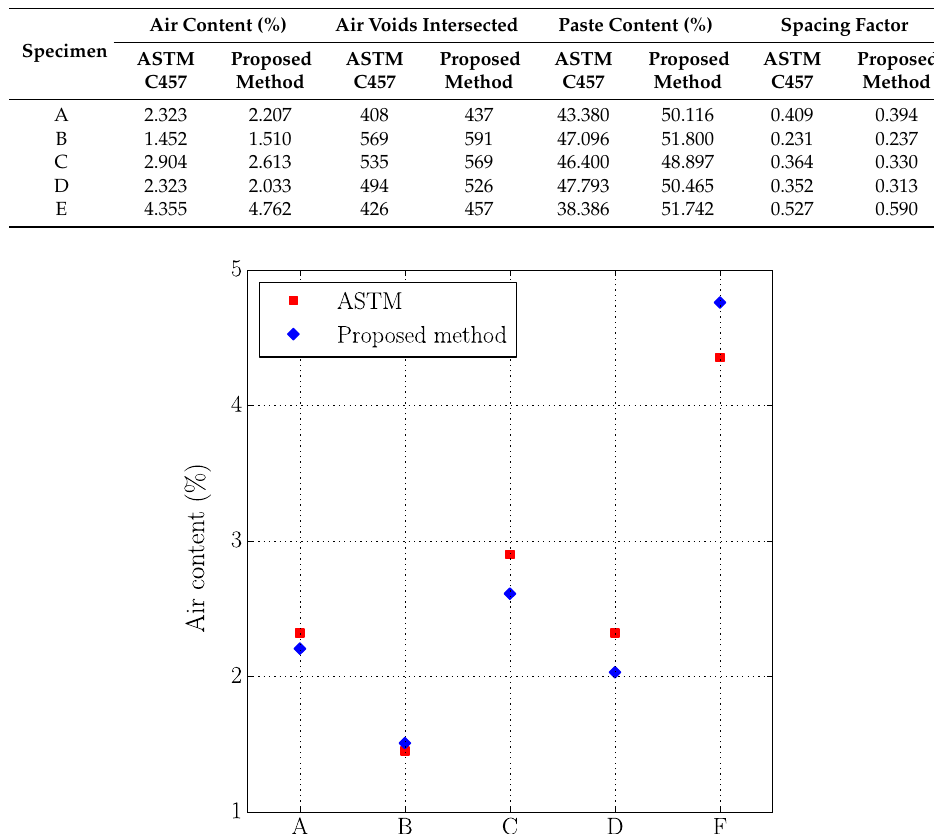
Figure 10. Results of the voids intersected of the slabs studied using the original and the proposed methods.